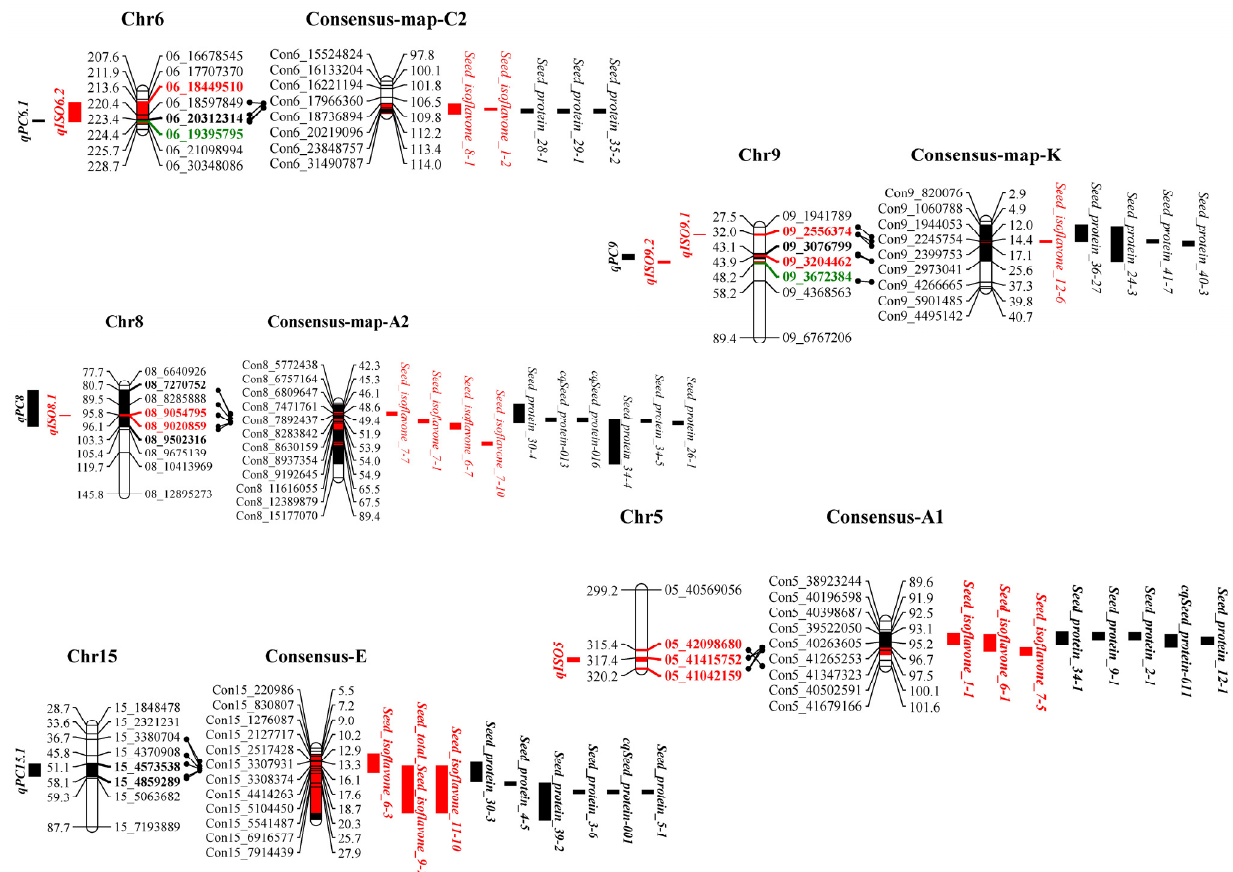
Figure 4. Colocalization of isoflavone and protein loci identified in the current population with loci identified in previous studies. Colors and bold fonts represent identified loci. Red and black blocks represent loci of isoflavone and protein traits, respectively. Projected regions are highlighted in corresponding colors. Bold markers in different colors indicate the boundaries of corresponding loci, with green indicating markers for both the isoflavone and protein traits. The consensus map shows previously identified loci for isoflavone or protein production based on soybase data.